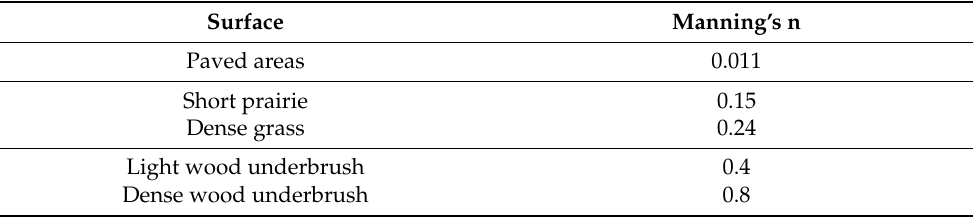
Table 1. Adopted Manning’s n for overland flow